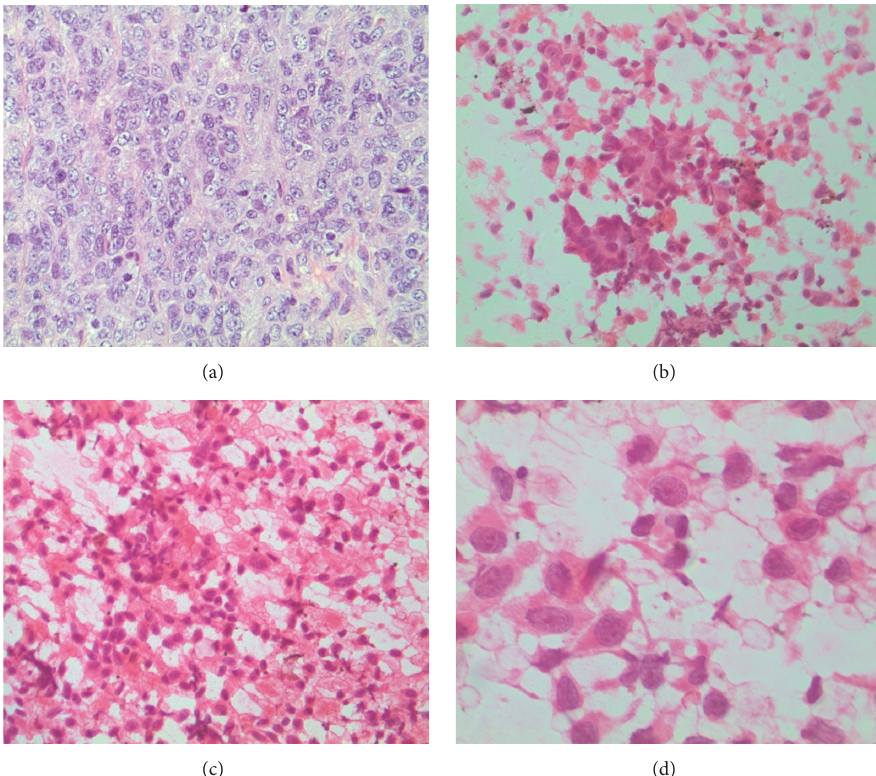
Figure 4: Histology and cytology of malignant PEComa. (a) Sheets of polygonal epithelial cells with hyperchromatic nuclei with prominent nucleoli and brisk mitotic activity (H&E, 400x). (b) Epithelioid cell clusters in a hemorrhagic background (Papanicolaou stain, 400x). (c) Medium cellular aspirate in hemorrhagic background (Papanicolaou stain, 400x). (d) Pleomorphic cells with enlarged nuclei with conspicuous nucleoli and light eosinophilic cytoplasm (Papanicolaou stain with oil, 1000x).